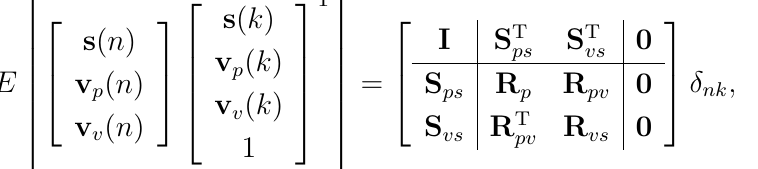
Figure 9 . Block diagram of (a) implementation of the Kalman filtering virtual sensing method and (b) the generalised control configuration with two sets of inputs and two sets of outputs [53]. identification stage with microphones temporarily positioned at the virtual locations. The primary distur- bance signals, s ( n ) , the physical measurement noise signals, v ( n ) , and the virtual measurement p